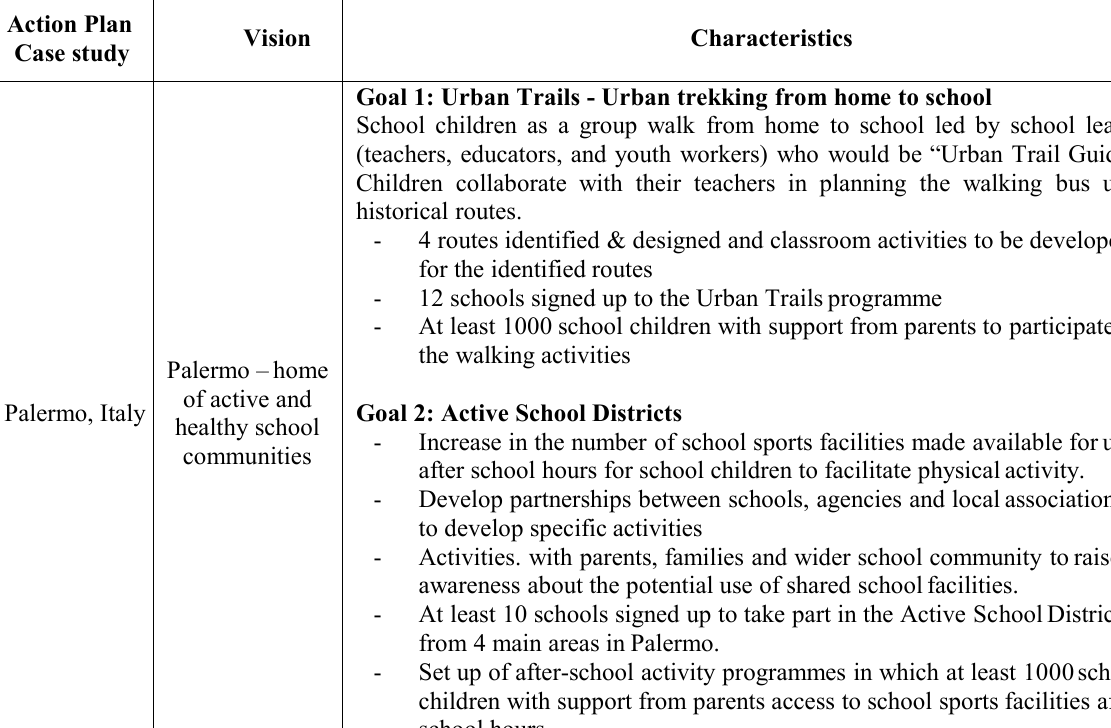
Table 2 – Summary of the UActivE Action Plan realized in Palermo,